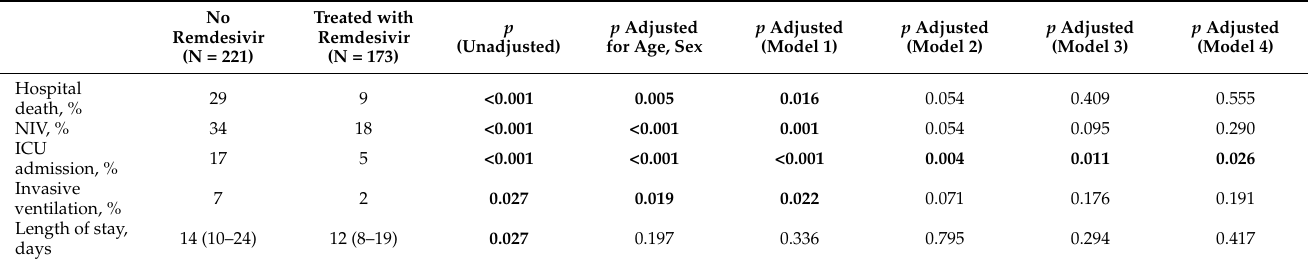
Table 3. Comparison of study outcomes between patients who received remdesivir during hospital stay and those who did not.